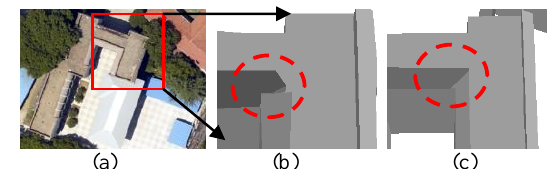
Figure 9. Topologic reconstruction (Figure 8e) between two roof primitives: (a) image, (b) from the graph matching approach, and (c) from our global approach.